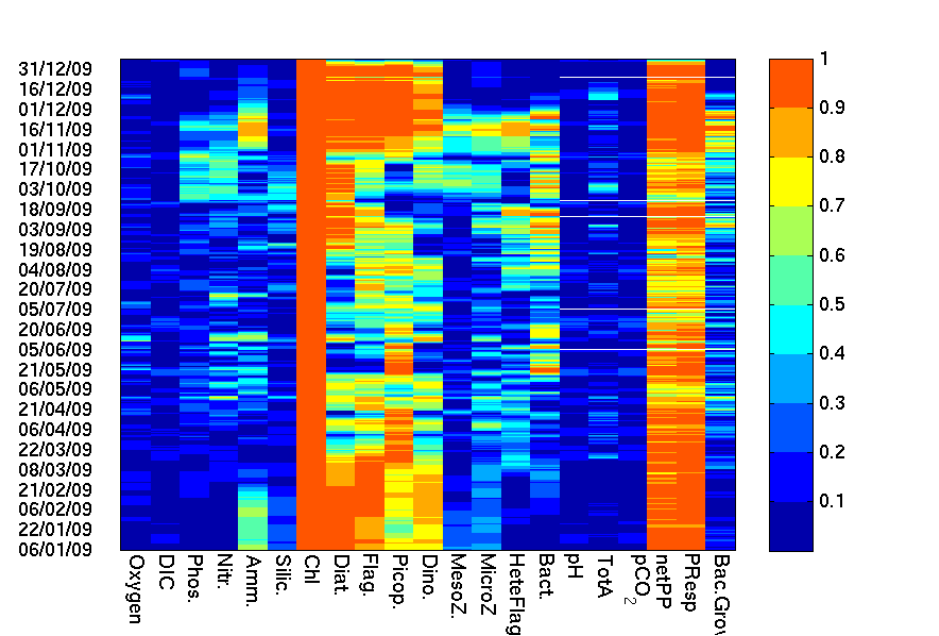
Figure 12. Time evolution for 2009 of the cross-correlation matrix across ensemble members for Experiment D. The colors indicate the correlation of each variable with the top 10 m mean of total